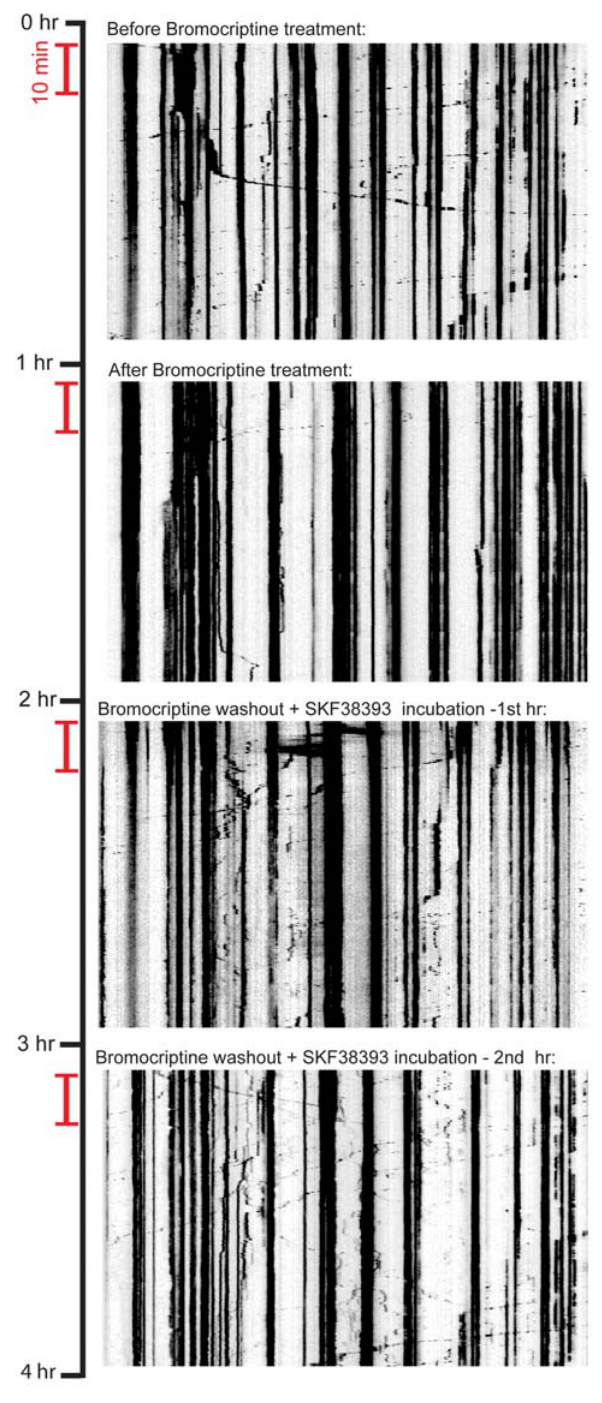
Figure 6. Modulation of mitochondrial movement by D2R and D1R agonists is reversible. Kymographs of mitochondrial motility shown in supplementary movies (Movies S13-S16); vertical scale bar=10 minutes. In the experiment, a segment of axon was imaged continuously for four hours (with short breaks to allow for exchange of media and administration of drugs) at 10-second intervals. Hour 1: before treatment, basal level of mitochondrial movement. Hour 2: treatment with bromocriptine. Hour 3: washout of bromocriptine, and addition of SKF38393. Hour 4: one hour incubation with SKF38393.